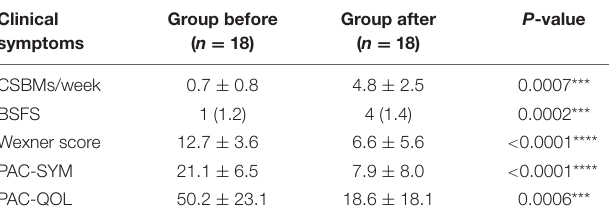
TABLE 2 | Evaluation of FC patients’ clinical symptoms before and after FMT.